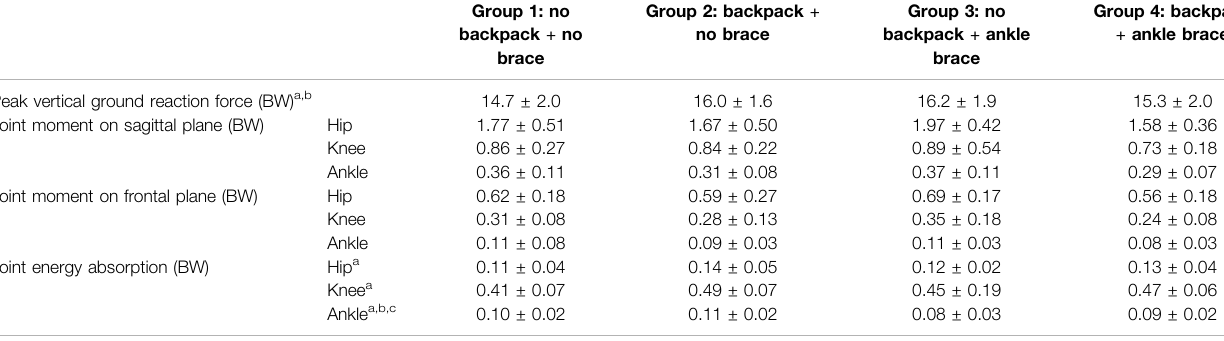
Group 1: no Group 2: backpack + backpack + no no brace brace